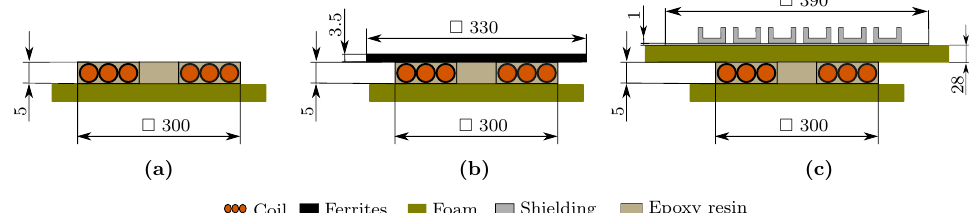
Figure 4. Component testing: experimental setups of ( a ) coil, ( b ) ferrites, and ( c ) shielding with heat sinks (dimensions in mm).